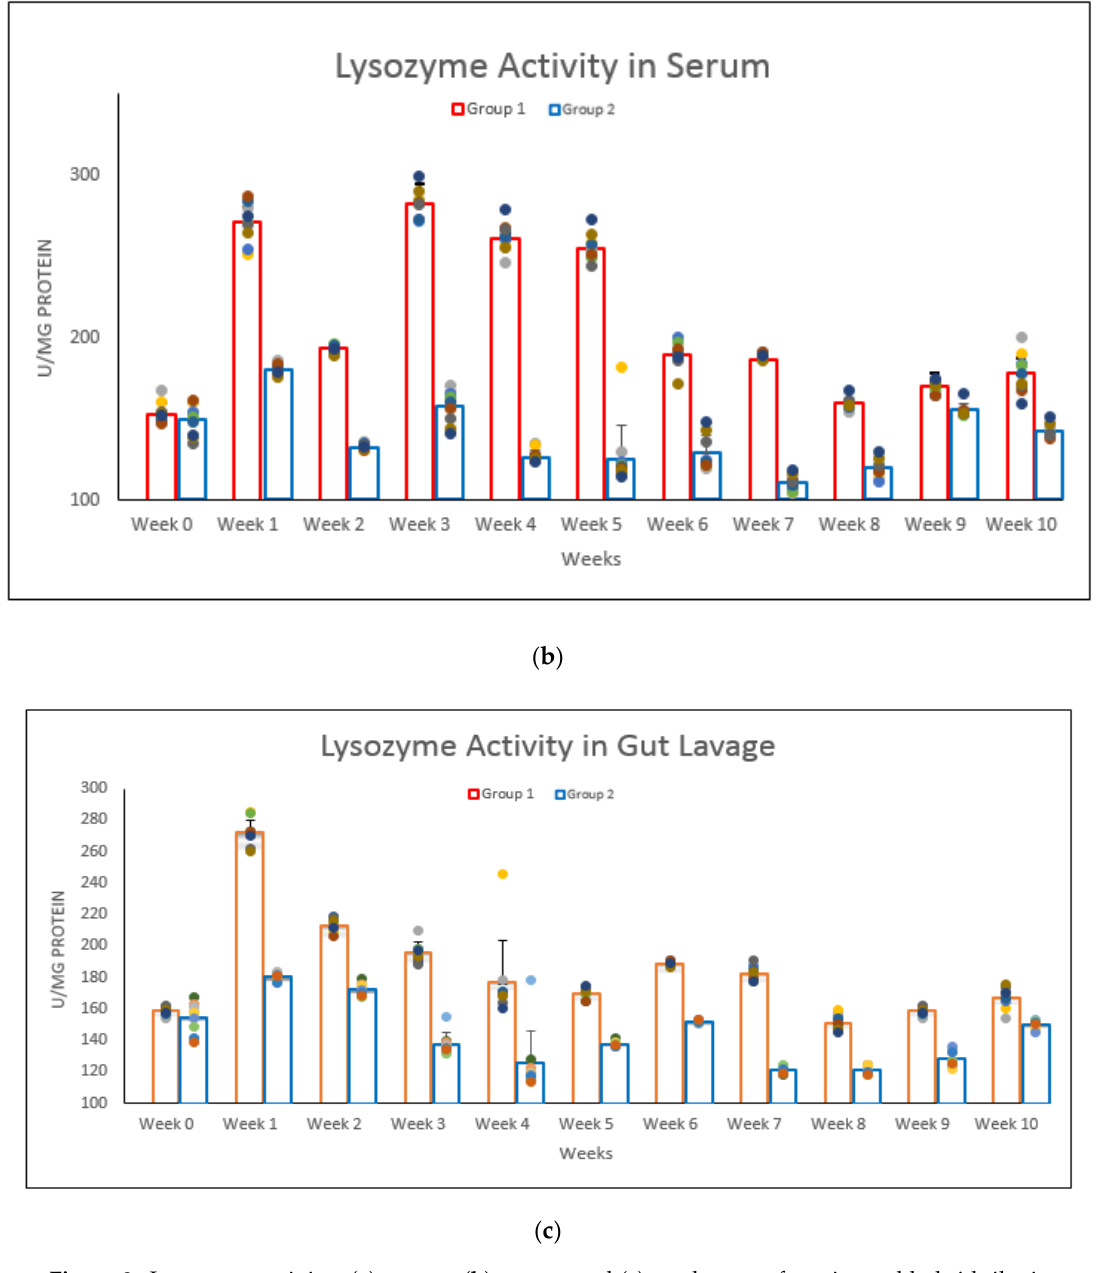
Figure 3. Lysozyme activity: ( a ) mucus, ( b ) serum, and ( c ) gut lavage of marine red hybrid tilapia following vaccination with formalin-killed V. harveyi for both Group 1 and 2. Relatively, the lysozyme activity was plotted directly with the value of the optical density, which was inversely converted. Error bar indicates significant di ff erences at p < 0.05. The di ff erent dot colors from each bar indicated several readings each weeks from each groups.